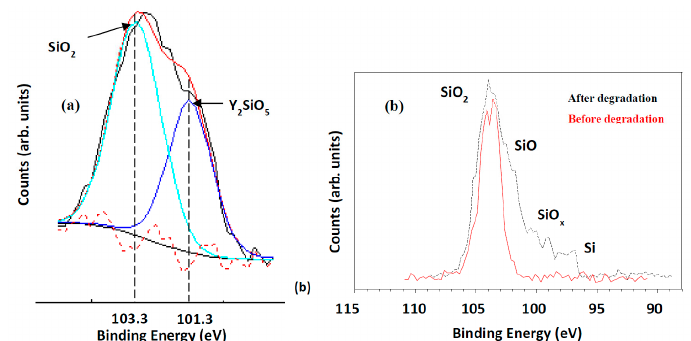
Figure 8. ( a ) XPS fitted results for the Si 2p in the Y 2 SiO 5 :Ce after degradation [42] 24 h degradation in an oxygen pressure of 1 × 10 − 6 Torr with the electron current density at 26.3 mA·cm − 2 ; and ( b ) the XPS of SiO 2 :PbS nanoparticles before and after degradation [47] with a 2 keV electron beam at a 1 × 10 − 7 Torr O 2 pressure.